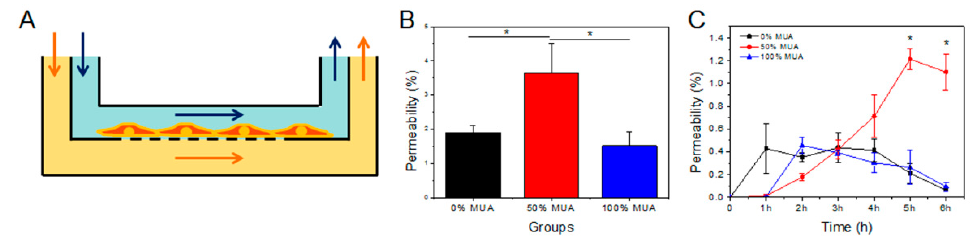
Figure 4. Permeability of GNPs with different surface modifications in the microfluidic chip. ( A ) Human gut-on-a-chip. Schematic of the gut-on-a-chip device showing a flexible porous polylysine-coated membrane lined by gut epithelial cells crossed horizontally through the microchannel. ( B ) Aggregate permeability of the three GNPs tested by the microfluidic chip over 6 h. * p < 0.05. ( C ) Permeability of the three GNPs tested by the microfluidic chip each hour over 6 h.